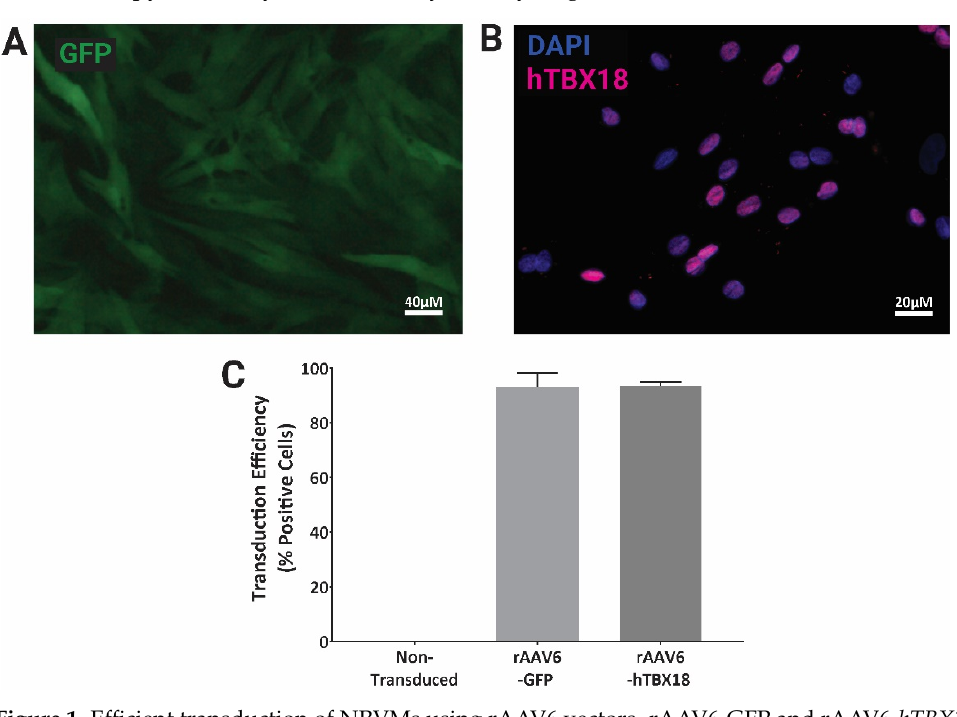
Figure 1. Efficient transduction of NRVMs using rAAV6 vectors. rAAV6-GFP and rAAV6- hTBX18 transduction efficiency in NRVMs as visualized via microscopy and quantified via flow cytometry. ( A ) GFP fluorescence in NRVMs transduced with rAAV6- GFP. ( B ) NRVMs transduced with rAAV6- hTBX18 , then co-stained with hTBX18 antibody and DAPI. ( C ) Transduction efficiencies of NRVMs transduced with rAAV6- GFP and rAAV6- hTBX18 , as quantified via flow cytometry. Data presented as mean ± SEM. n = 2